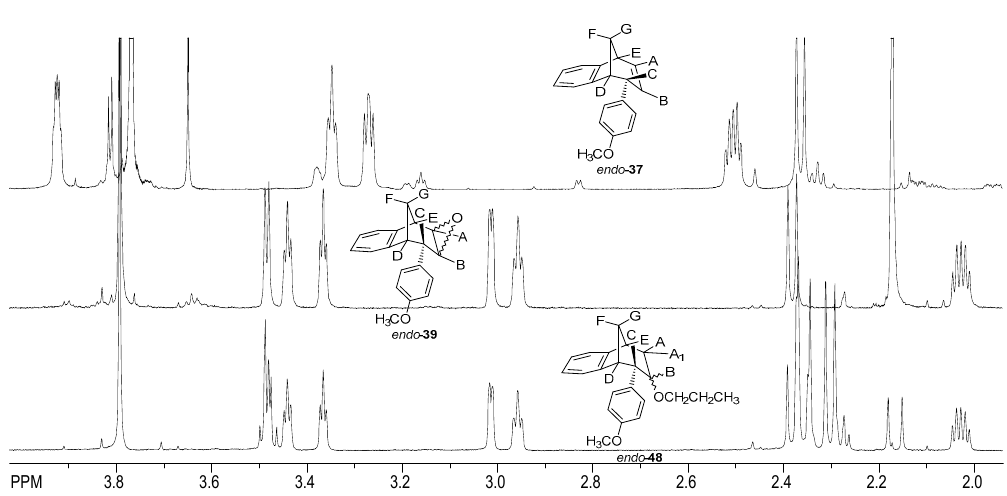
Figure 11. Partial 1 H NMR spectra of starting compound endo - 37 and reaction products epoxyde endo - 39 and ether endo - 48 .